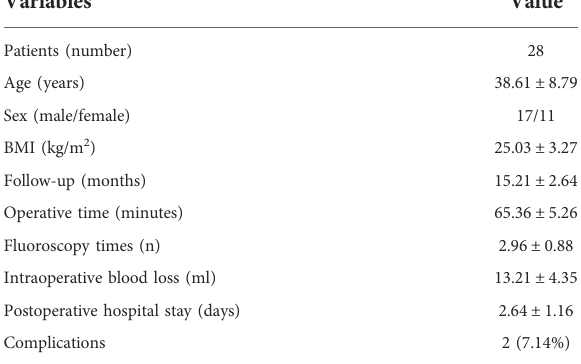
TABLE 1 Demographic characteristics and surgical outcomes of all patients. Variables